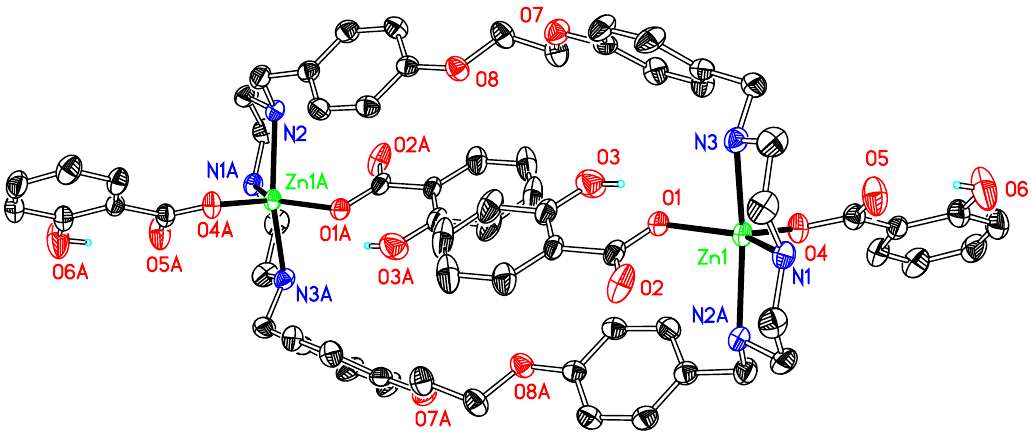
Figure 5. Thermal ellipsoid plot, drawn at the 50% probability level, of [Zn 2 ( o -OCOPhOH) 4 L 1 ] ( 5 ) with atomic numbering scheme. All H atoms, along with the solvents are omitted for clarity. Symmetry codes: A − x, 1 − y, 1 − z. Selected bond lengths (Å) and angles ( ◦ ): Zn1–N1 2.096(3), Zn1–N2A 2.260(3), Zn1–N3 2.236(3), Zn1-O1 1.995(3), Zn1–O4 1.980(3); N1–Zn1–N2A 80.21(12), N2A–Zn1–N3 155.18(13),